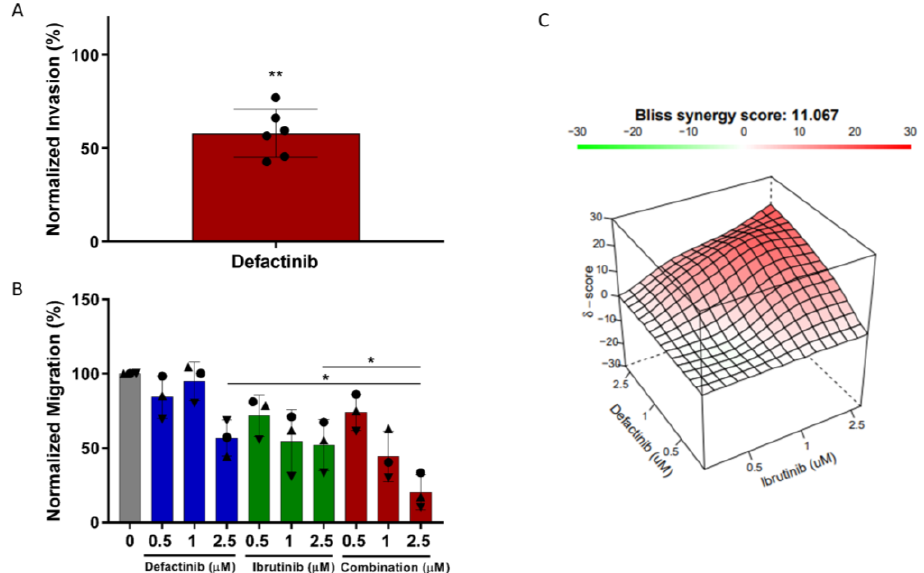
Figure 4. Pharmacological inhibition of FAK activation reduces CLL invasion and is synergistic